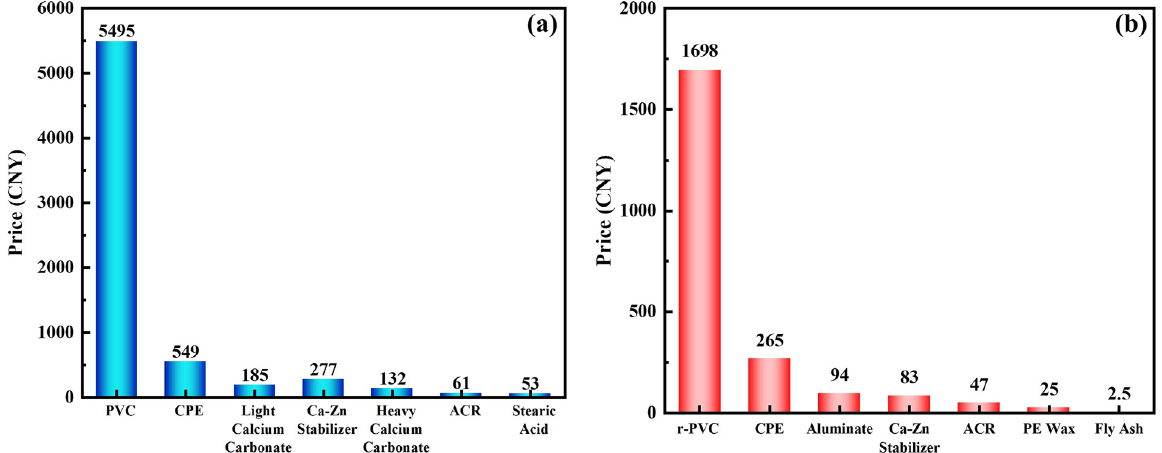
Figure 10: Production of per ton composites cost estimates: ( a ) traditional CaCO 3 - based DWSF composites and ( b ) new CFA - based DWSF